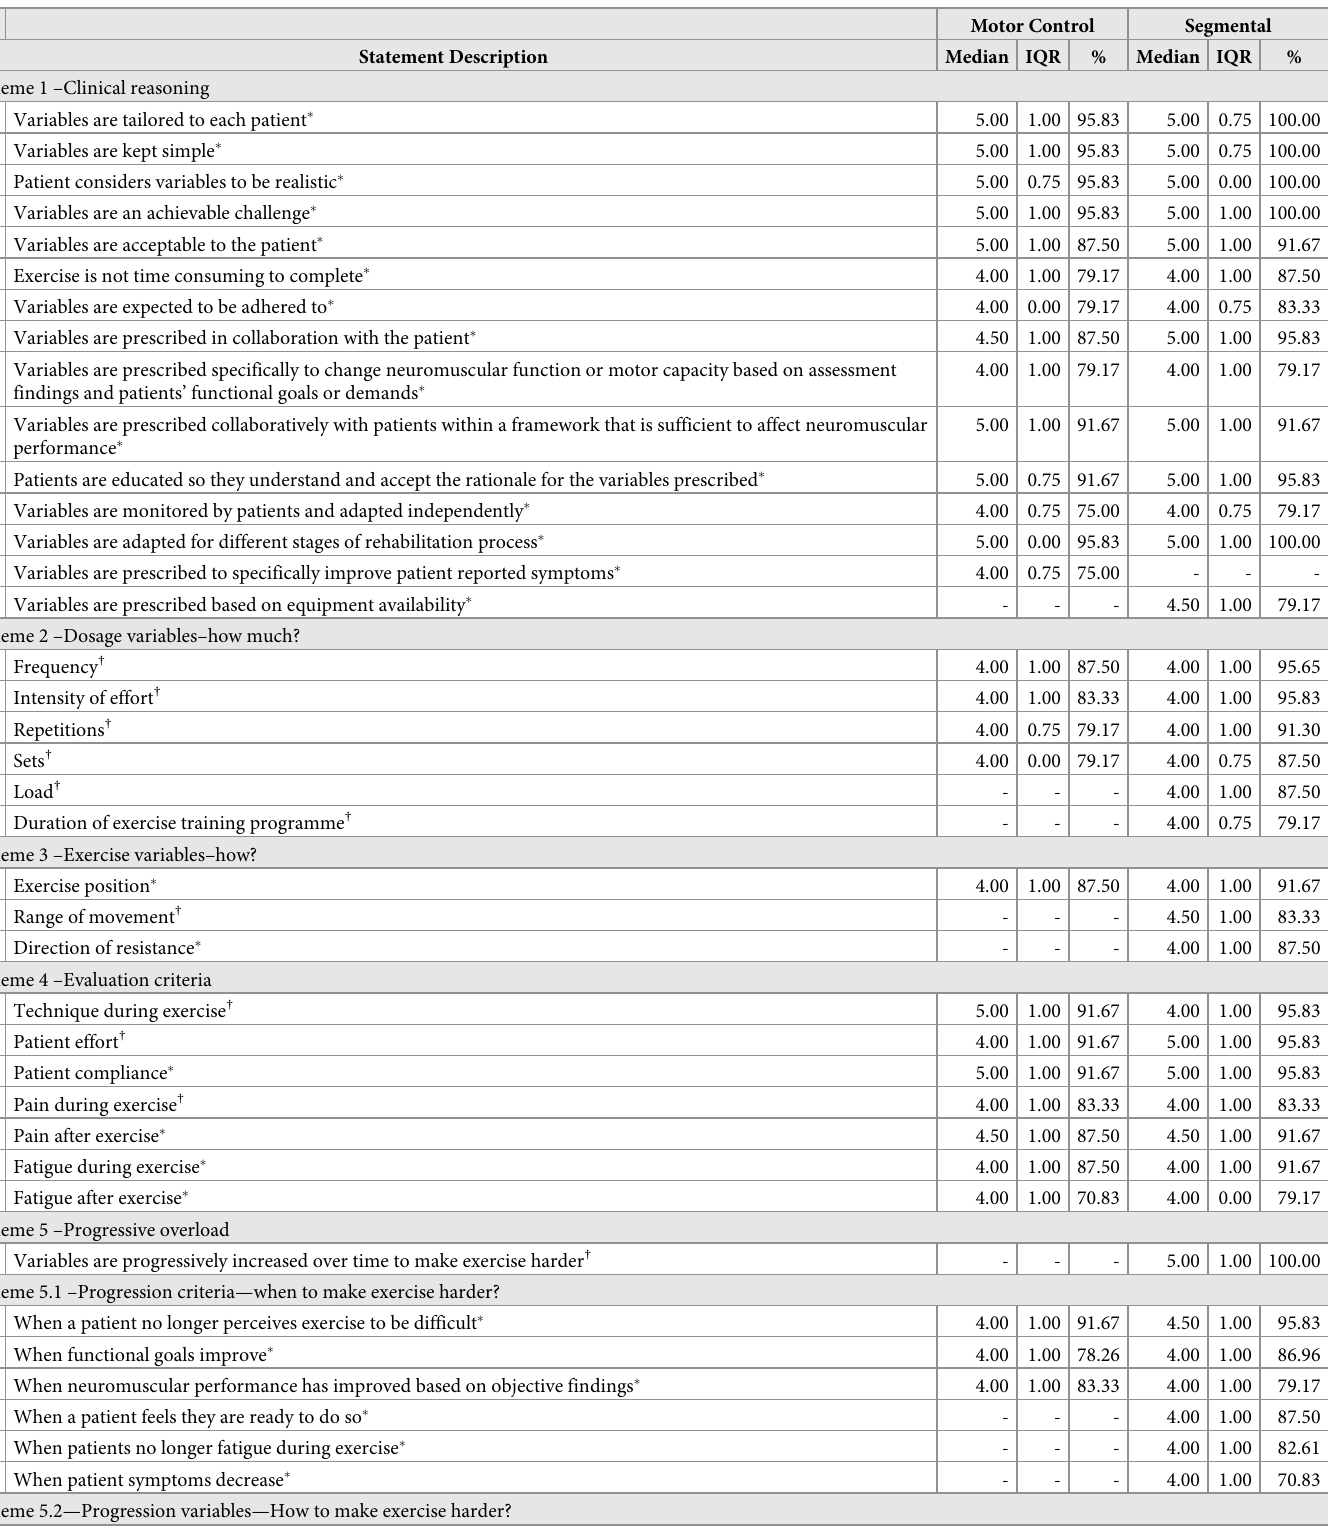
Table 4. Statements achieving consensus post round